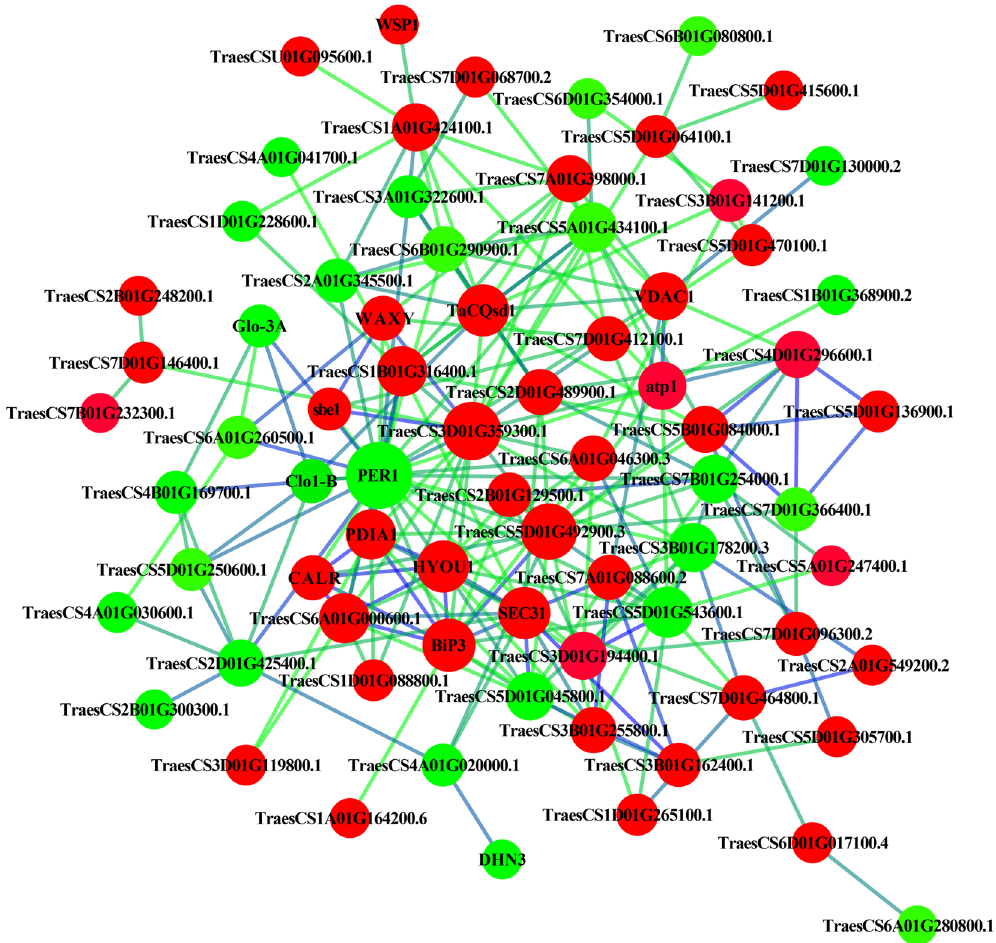
Figure 5. Protein–protein interaction network of protein species that are differentially accumulated between NIL-723 and NIL-1010. A green background indicates down-regulation of protein species, a red background indicates up-regulated protein species. The networks between NIL-723 and NIL-1010 were visualized with Cytoscape software (version 2.8.2, https:// cytos cape.